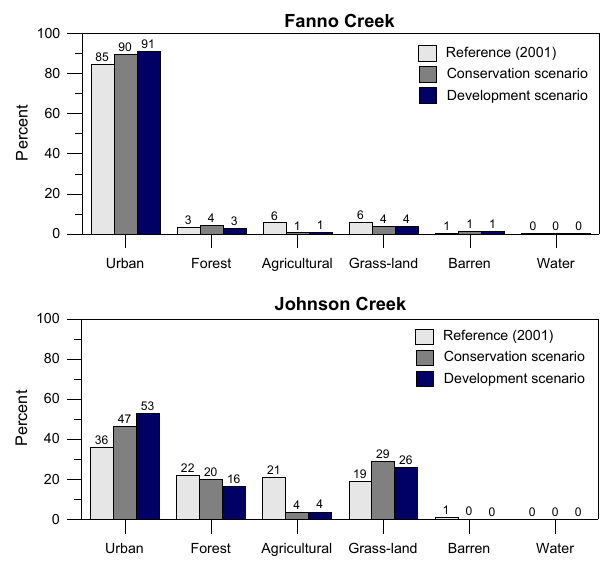
Fig. 5. Land use categories (%) for reference land use in 2001 and two future land use change scenarios for the 2050s 4